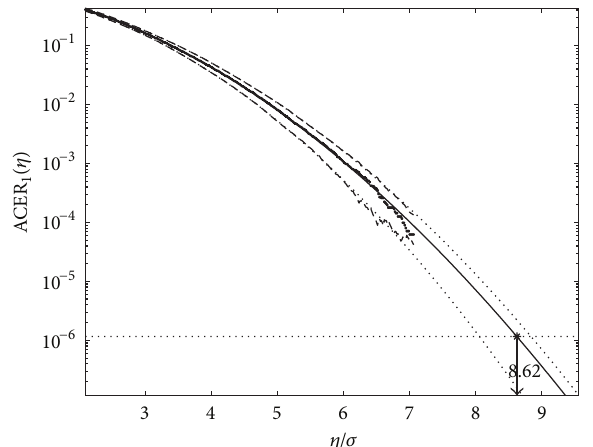
Figure 8: Nordøyan wind speed statistics, 13 years of hourly data. Gumbel plot of yearly extremes. Lines are fitted by the method of moments—solid line (—) and the Gumbel-Lieblein BLUE method—dash-dotted lite (- ⋅ -). 𝜎 = 6.01 m/s.